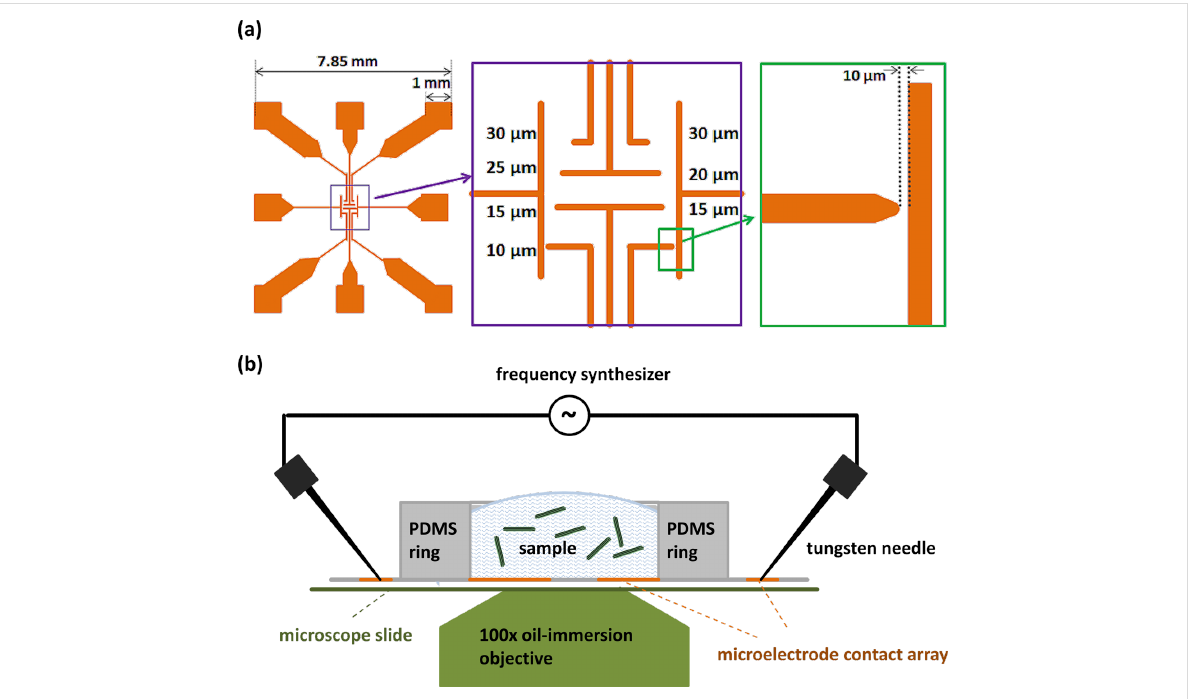
Figure 2: Experimental set-up for the investigation of the dielectrophoretic trapping. Schematic image of the (a) microelectrode contact array and (b) experimental set-up.